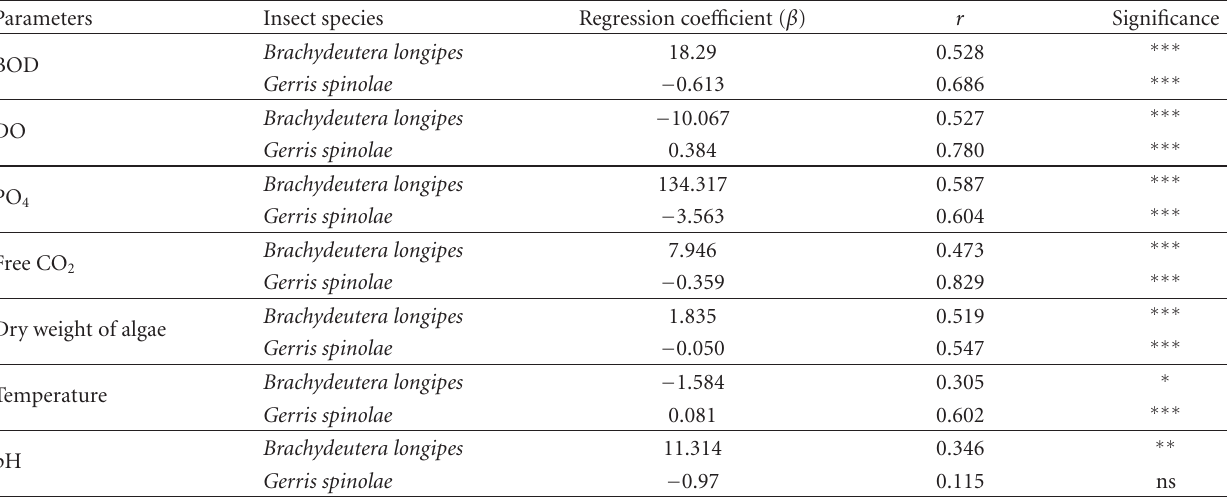
Table 2: Regression analysis output obtained by corelating each variable (water quality parameter) independently with the abundance of each of the two insect species, Brachydeutera longipes and Gerris spinolae.